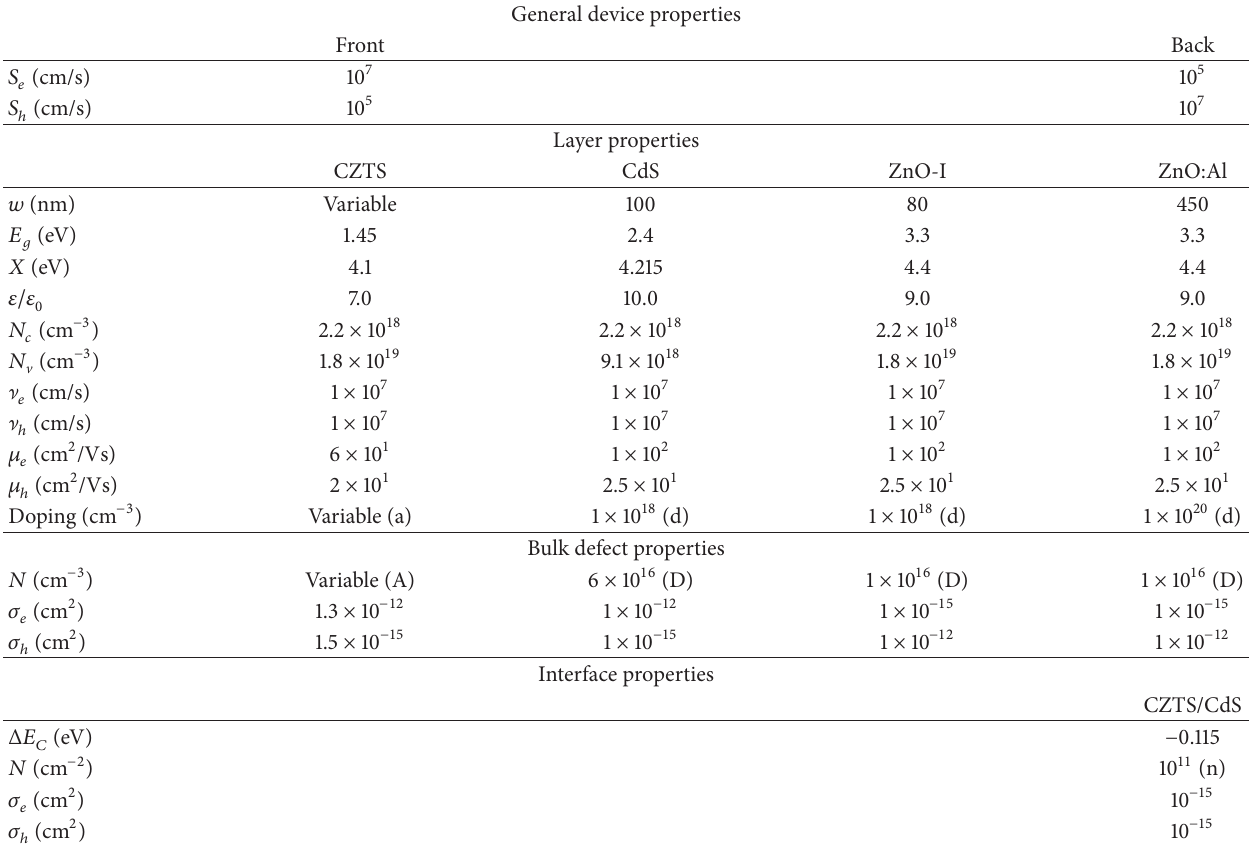
Table 1: Baseline parameters for modeling CZTS solar cells [9, 13, 14].